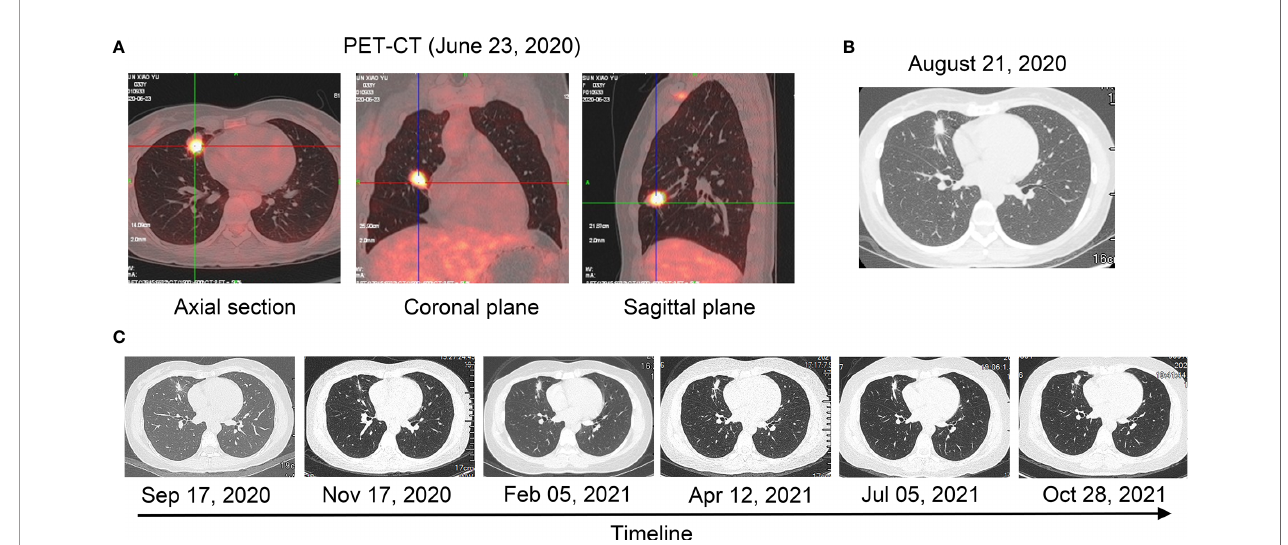
FIGURE 1 | Radiological examinations during the treatment course. (A) PET/CT scan before treatment (23 June 2020). (B) A computer tomography scan after treatment with crizotinib for 6 weeks (21 August 2020). (C) A computer tomography scan after treatment with crizotinib from 17 September 2020 to 28 October